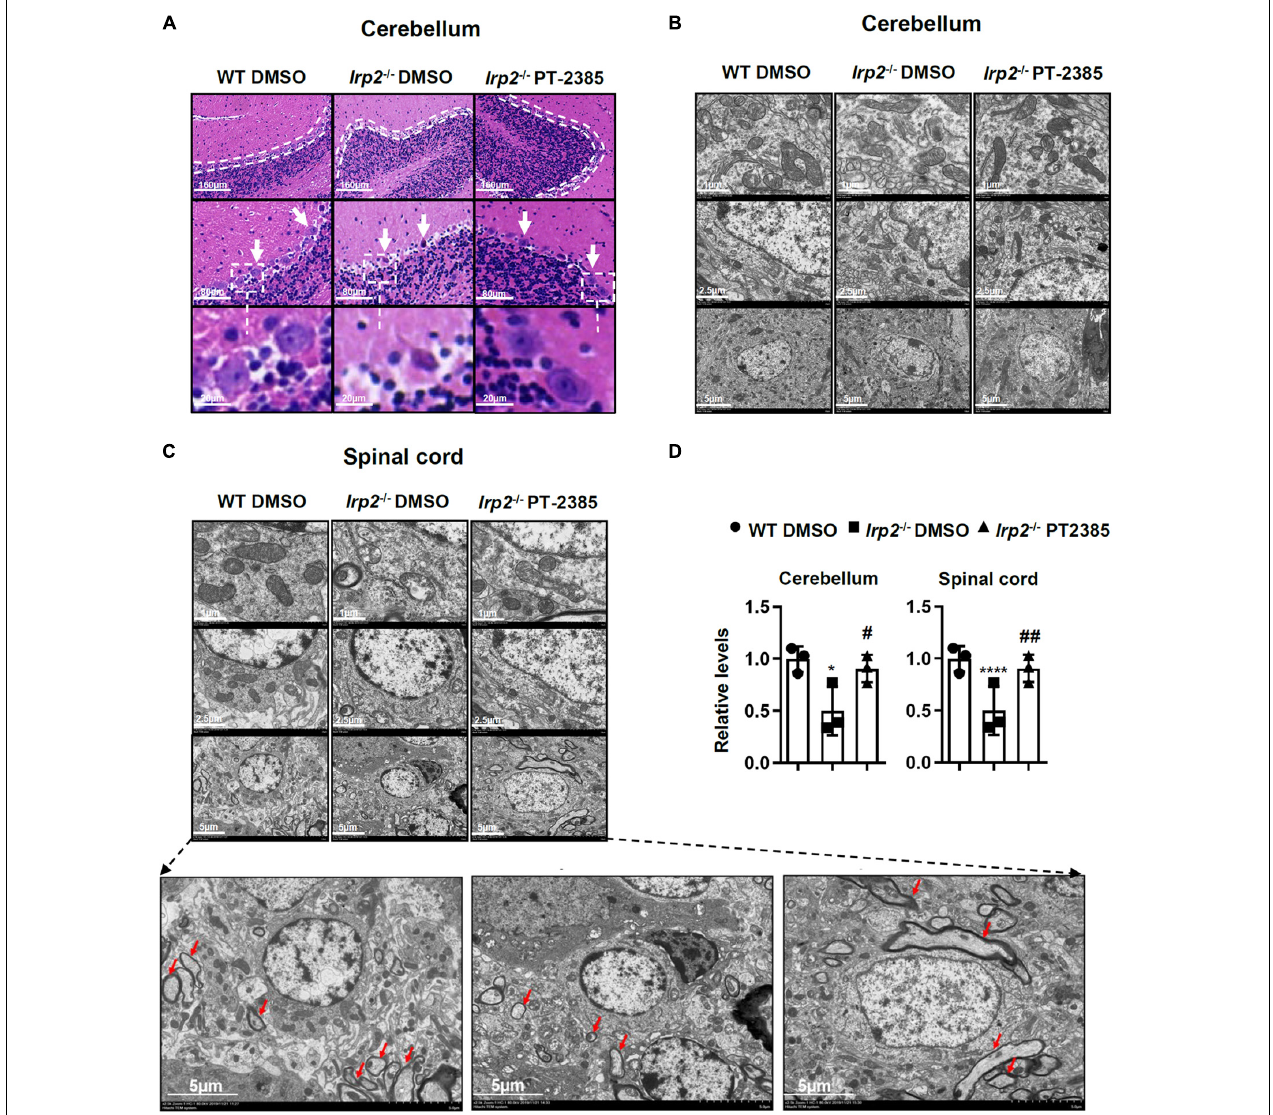
FIGURE 3 | The histological morphology and mitochondrial ultrastructure in the spinal cord and cerebellum of Irp2 − / − mice are improved after PT-2385 administration. (A) The hematoxylin–eosin (H&E)-stained sections of the cerebellum of WT DMSO, Irp2 − / − DMSO, and Irp2 − / − PT-2385 mice. The dotted lines indicate Purkinje cell layers (top), and the arrows point to Purkinje cells (middle). The Purkinje cells framed by the dotted line are magnified four times (bottom). The scale bars are 160, 80, and 20 µ m, respectively. (B,C) Transmission electron micrographs of the cerebellum (B) and spinal cord (C) of WT DMSO, Irp2 − / − DMSO, and Irp2 − / − PT-2385 mice. The scale bars are 1, 2.5, and 5 µ m, respectively. The bottom panels are magnified images of myelin sheath and axonal degeneration. (D) The quantification of a normal mitochondria (relative ratio comparing with that in WT). Values represented the mean ± SD, n = 3. The ANOVA was used for statistics to evaluate the group differences. * P < 0.05, **** P < 0.0001, Irp2 − / − DMSO vs. WT DMSO; # P < 0.05, ## P < 0.01, Irp2 − / − PT-2385 vs. Irp2 − / −